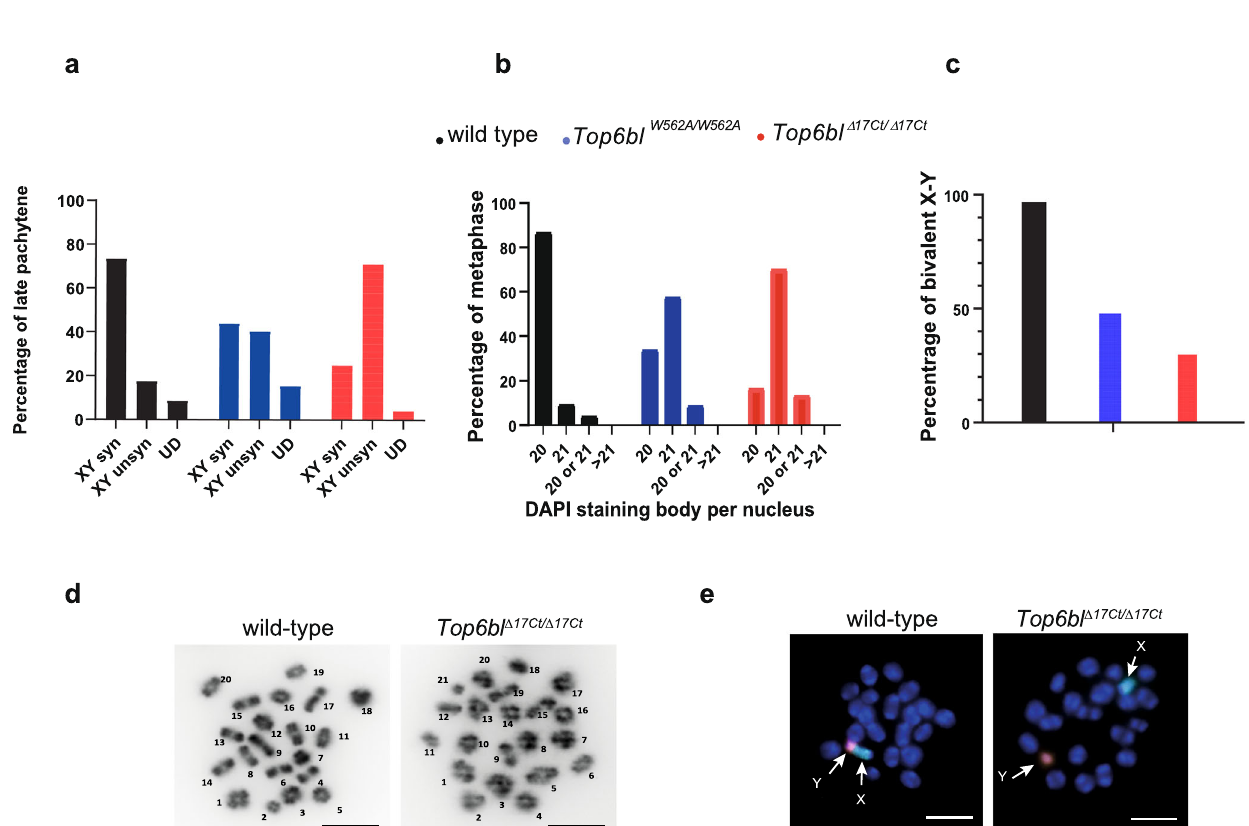
Fig.6|ProperDMC1-SSDSsignallocalisationandintensity,exceptedforq-arm sub-telomeric regions in Top6bl Δ 17Ct/ Δ 17Ct spermatocytes. a In Top6bl Δ 17Ct/ Δ 17Ct sper- matocytes, almost all wild-type hotspots and 20% of new hotspots are detected. b DMC1-SSDSsignalcorrelationbetweenwild-typeand Top6bl Δ 17Ct/ Δ 17Ct miceatwild- type hotspots. The Spearman rho and associated p-value (two-sided) are shown. Ten telomere-proximal hotspots are highlighted for each autosome (blue) and for the X chromosome (red). In the PAR, only part of the DMC1-SSDS signal, which covers a large domain (see panel d), is included within hotspots. c MA plot of the DMC1-SSDS signal in Top6bl Δ 17Ct/ Δ 17Ct compared with wild-type samples. The log2 of the ratios was calculated using DESeq2. Hotspot with signi fi cantly increased or decreased signal are highlighted in red ( n =214) and green ( n =1098), respectively (adjusted p value < 0.1). Unchanged hotspots are in grey ( n =8043). The mean normalized count corresponds to the baseMean value from the DESeq2 analysis. d DSBmapsofthe7Mbtelomere-proximalregionsofthechromosomes19andXin wild-type (blue) and Top6bl Δ 17Ct/ Δ 17Ct (green) mice. On chromosome X PRDM9- independent and -dependent hotspots as de fi ned by analysis in Prdm9 -/- mice 36 are identi fi ed by orange and blue triangles, respectively. The PAR is highlighted with a pink rectangle. All chromosome ends are shown in Supplementary Figs. 14, 15.